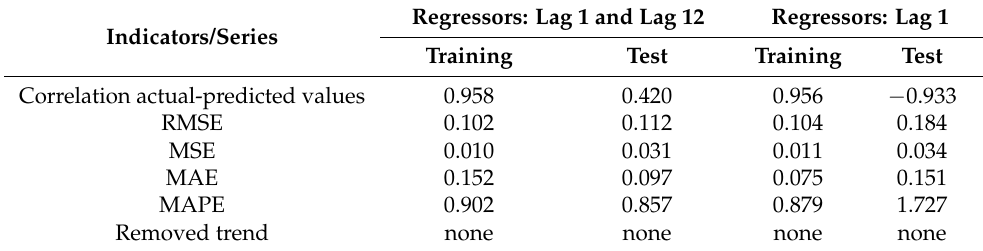
Table 11. Performances of the best models built for U1_ms.